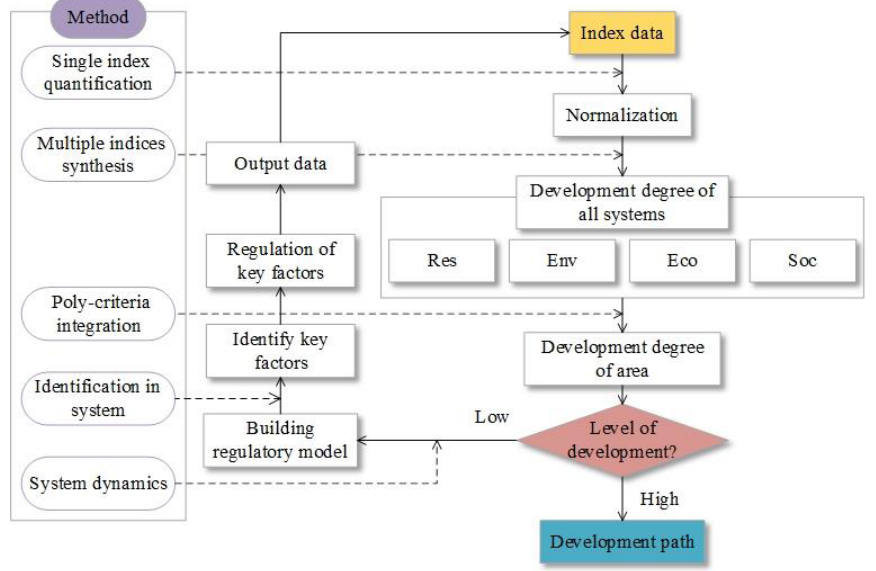
Figure 1. Study content flowcharts.